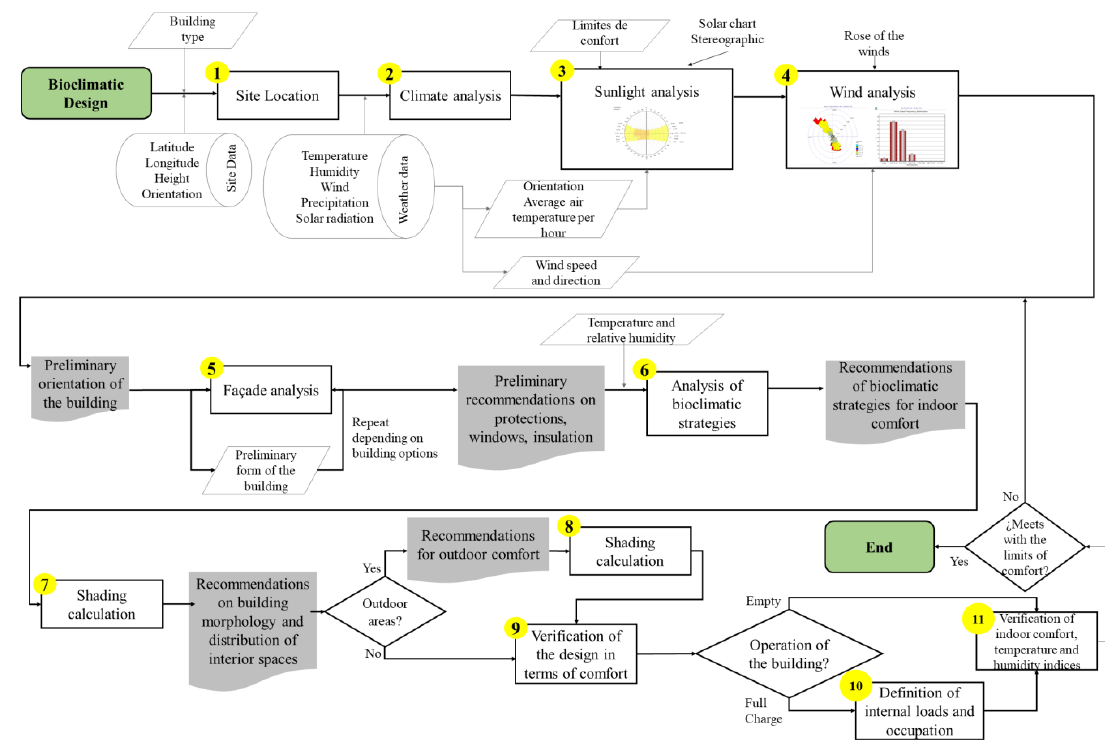
Figure 5. Flowchart of bioclimatic methodology. Own elaboration.